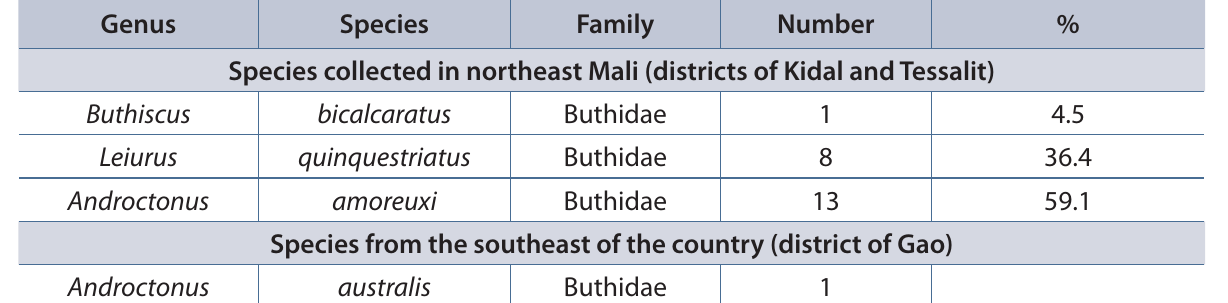
Table 1. List of scorpions examined